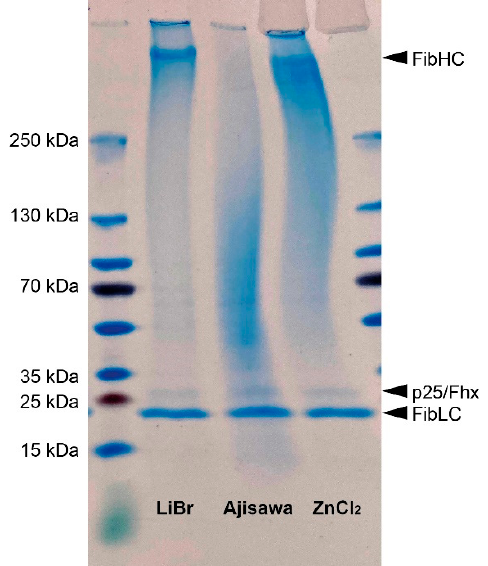
Figure 8. Comparison of molecular mass distribution of silk fibroin depending on isolation method by SDS-PAGE analysis. Films of all fibroin dissolved in LiBr, in Ajisawa’s reagent, or in ZnCl 2